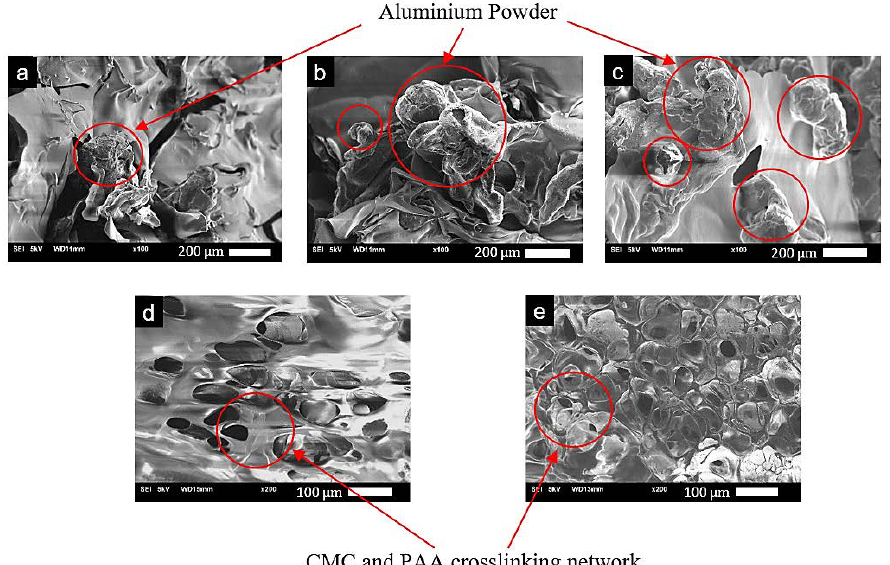
Figure 2. X - ray pattern for aluminum - based aerogel.